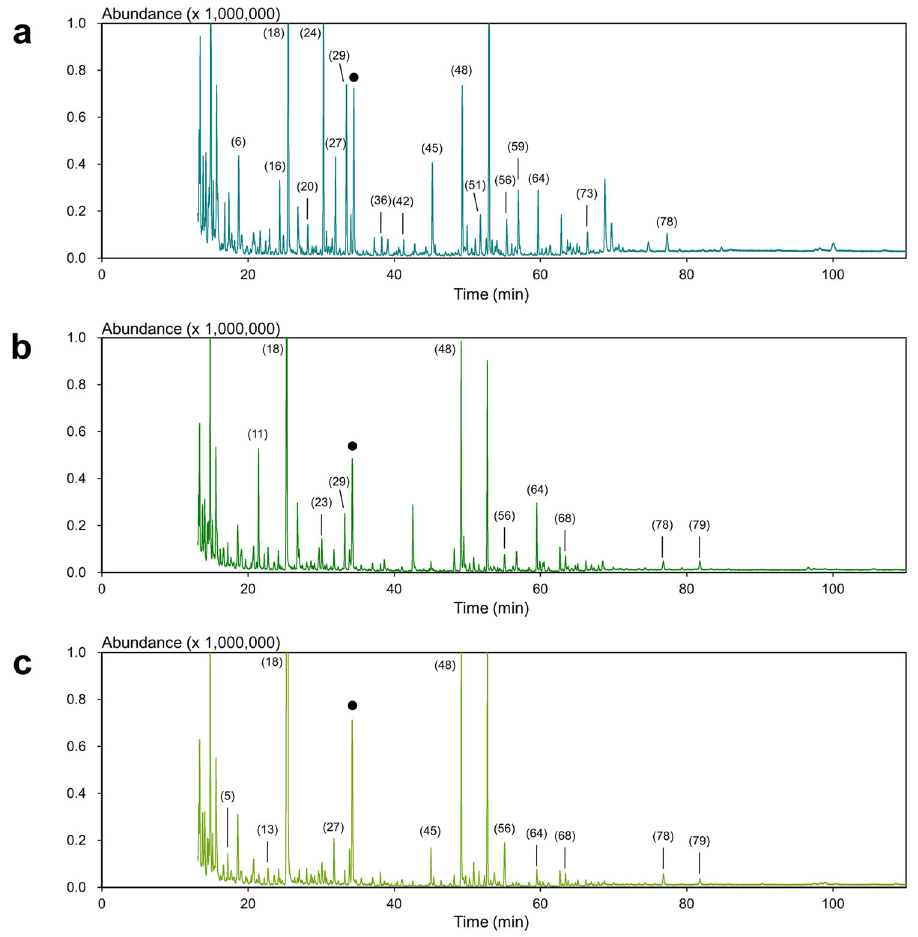
Fig. 4 GC – MS chromatograms of the EVOO extracts obtained by OA-LLE × 3 + SAFE. The chromatograms for cv. Hojiblanca, cv. Mission, and cv. Lucca are shown in a – c , respectively. OA-LLE was performed three times separately (15.0 g of EVOO, in total), and the dichloromethane layers were combined. The sample solution was subjected to SAFE. Numbers refer to the volatile compounds listed in Supplementary Table 3. The closed black circles ( ● ) indicate the peaks of the internal standard (0.005% (w/v)